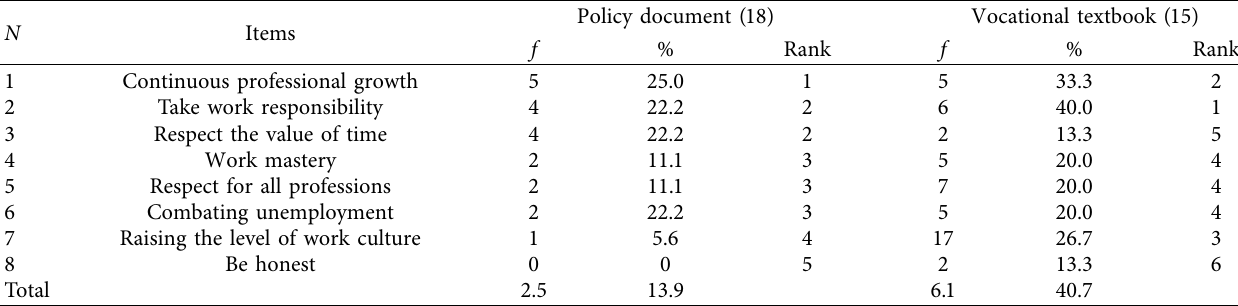
Table 4: The descending order of the economic values related to the work contained in the provisions of the Saudi Arabian vocational textbook (15 lessons) and the Educational Policy Document (18 parts).